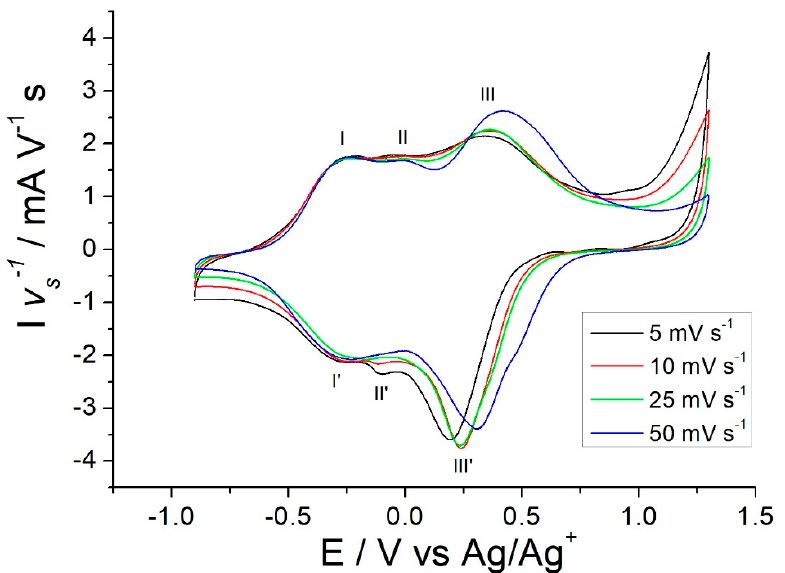
Figure 3. Scan rate-normalized cyclic voltammograms of poly-[Co(Amben)] in 0.1 M Et 4 NBF 4 /EC/DEC in the potential range between − 0.9 and +1.3 V at different scan rates.